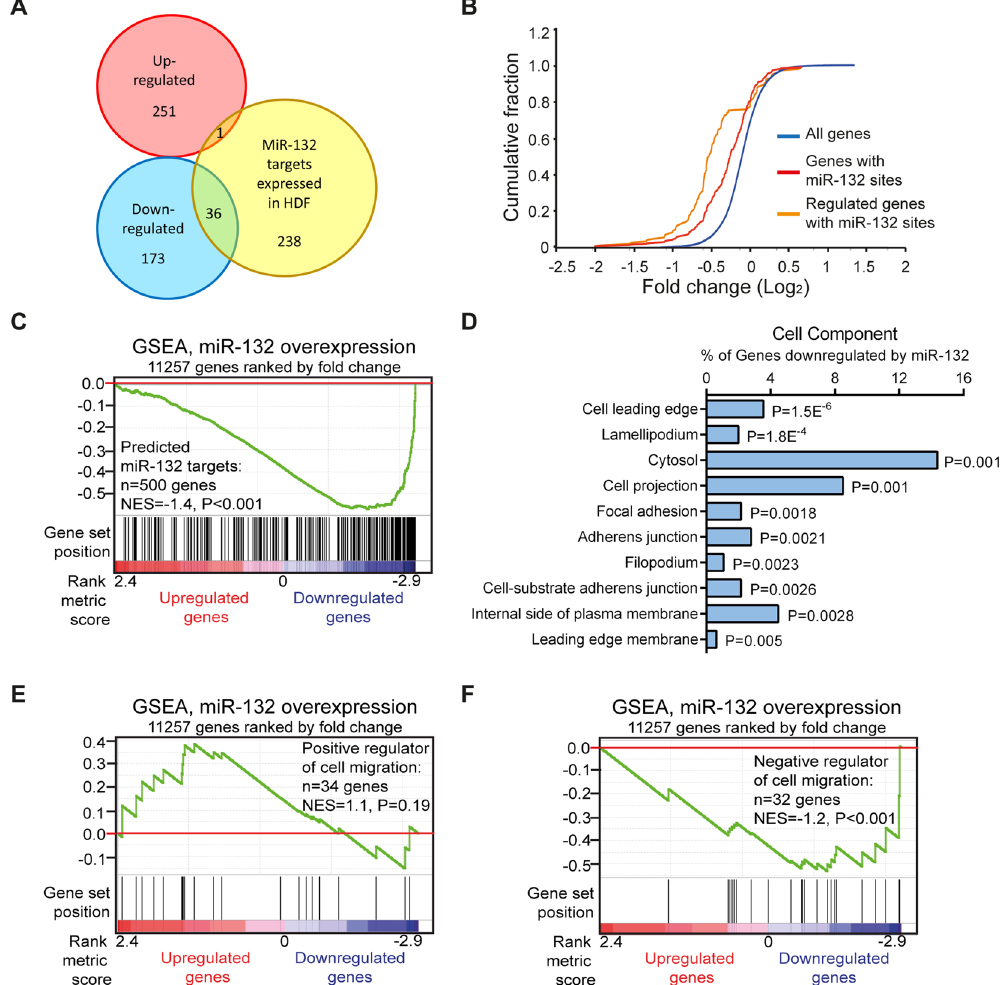
Figure 2. Transcriptome analysis of fibroblasts overexpressing miR-132. ( A ) Venn diagram depicting the number of genes significantly up- (red) or down-regulated (blue) by miR-132 (fold change ≥ 1.5, P < 0.05) and TargetScan predicted miR-132 targets that expressed in HDFs (yellow). ( B ) Cumulative distribution plots of log 2 -transformed fold-changes for genes predicted to contain miR-132 binding sites (red), genes with miR- 132 sites and regulated by miR-132 (orange) and all the genes detected by microarray (blue). ( C ) Genes in microarray data were ranked by fold change (miR-132 mimic / Ctrl mimic). GSEA evaluated enrichment within the profile data for the predicted target genes of miR-132. Vertical bars along the χ axis denote the positions of miR-132 target genes within the ranked list. NES, normalized enrichment score. ( D ) The top10 gene ontology cell component terms for the genes down-regulated by miR-132 in fibroblasts. P -values were determined by the Fisher’s exact test. GSEA evaluated enrichment within the microarray data for the genes reported to accelerate ( E ) or impair ( F ) cell